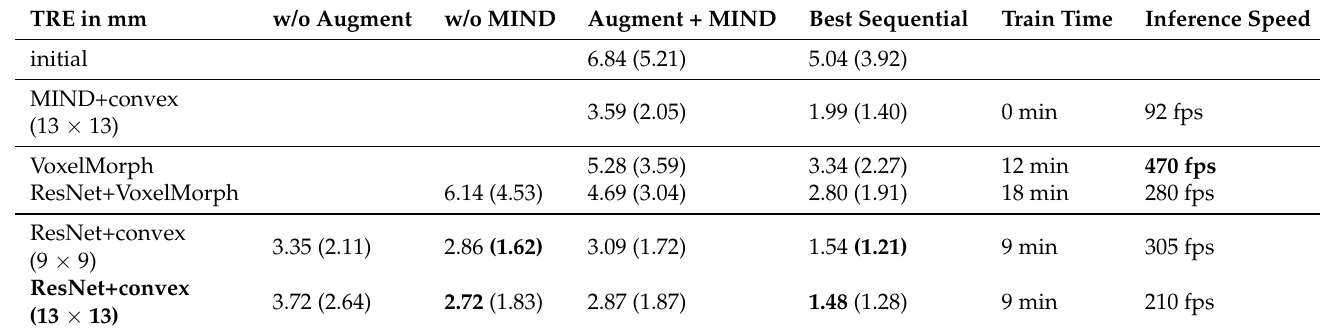
Table 1. Quantitative evaluation of five-fold cross-validation of all approaches on the ETHZ dataset . Target registration error (TRE) is shown as an average in mm, as well as the 90th percentile (in brackets), based on initial misalignment. Best results per category are set in bold. Our approach was superior to all compared methods in terms of accuracy. It was much faster than the second and third best approaches and required the least amount of training time (except for the untrained MIND variant). Note that the first three columns all show the unordered frame pairs